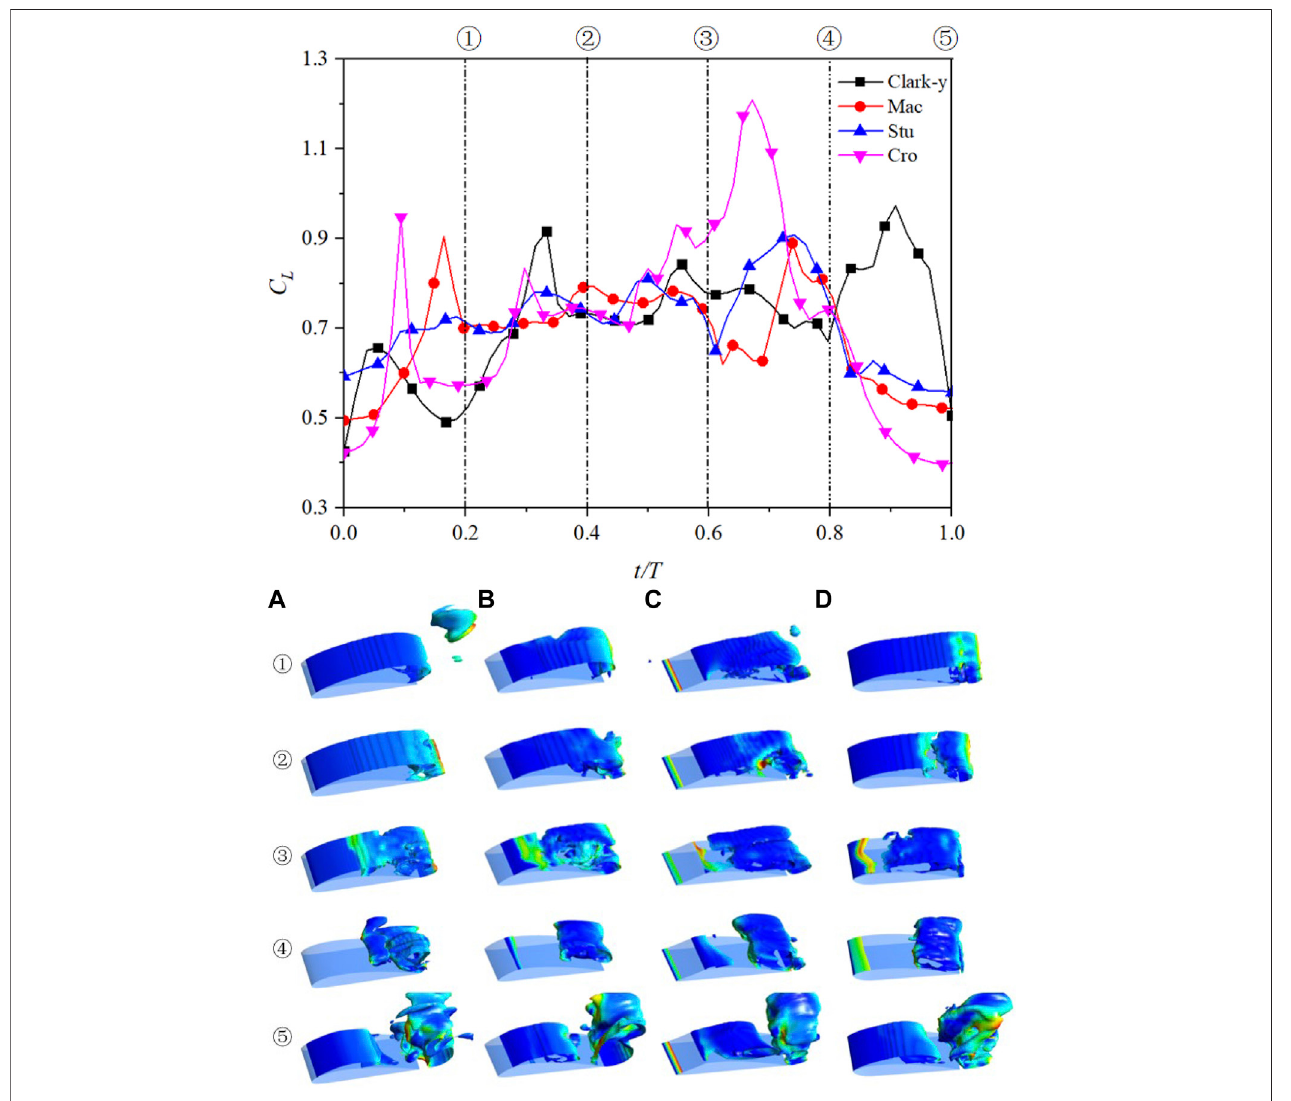
FIGURE 6 | Transient evolution process of the cavitating fl ow of the four hydrofoils in one cycle. (10% vapor volume fraction iso-surface) (A) Clark-y (B) Mac. (C) Stu. (D) Cro.